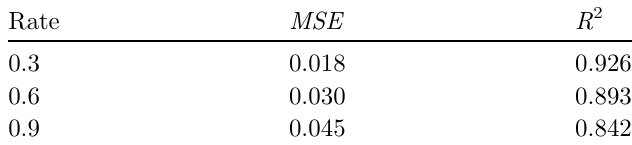
Table 2. The MSE and R 2 on training set at different speed